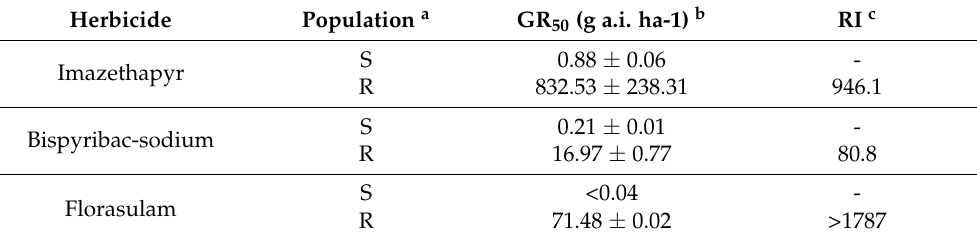
Table 4. GR 50 values of the Silene conoidea populations treated with ALS inhibitors and the resistance index (RI) indicated by the R/S